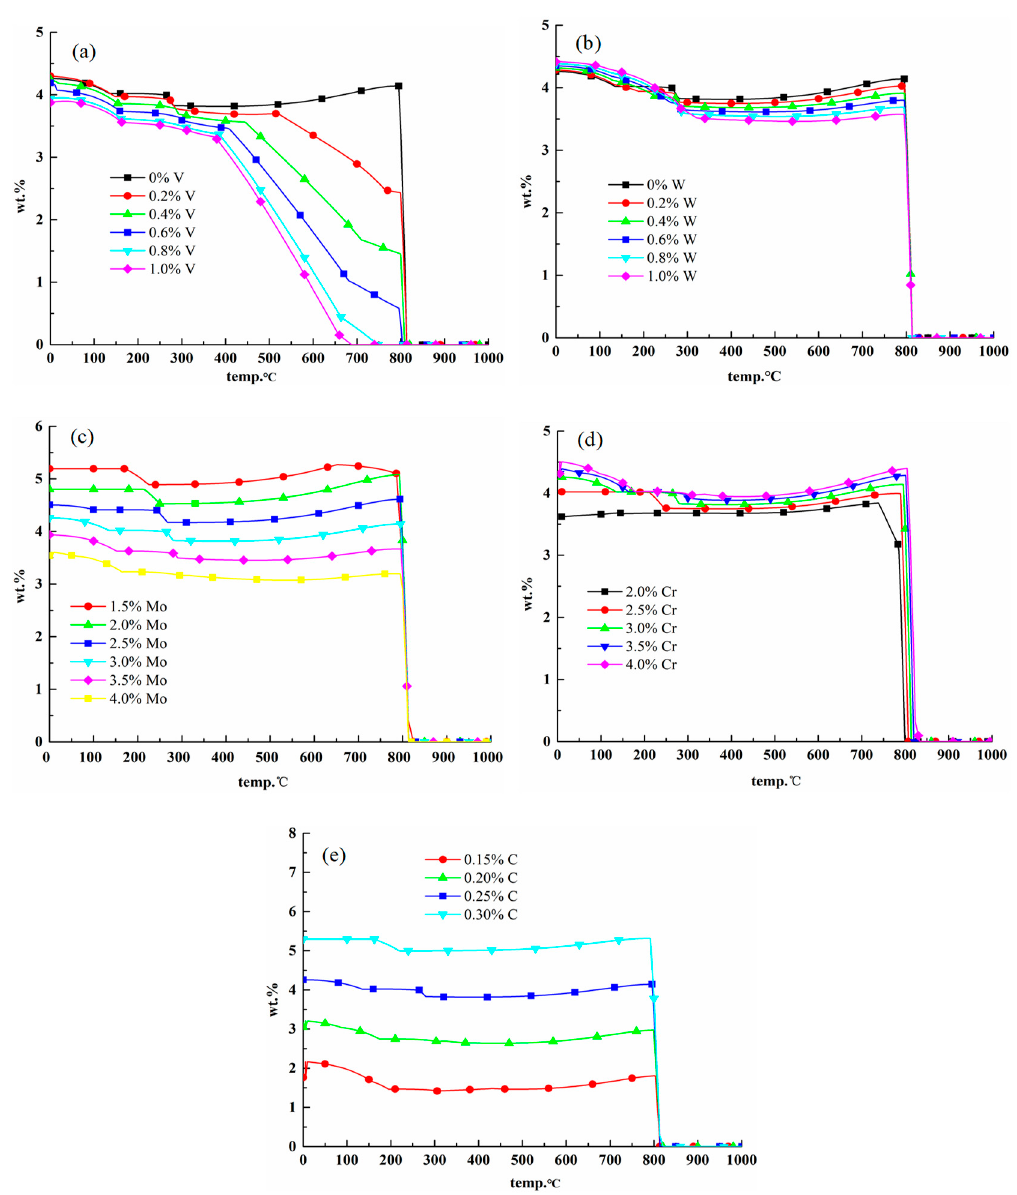
Figure 3. E ff ects of alloying elements on M 23 C 6 carbides. ( a ) E ff ect of V on M 23 C 6 ; ( b ) e ff ect of W on Figure 3. Effects of alloying elements on M 23 C 6 carbides. ( a ) Effect of V on M 23 C 6 ; ( b ) effect of W on M 23 C 6 ; ( c ) e ff ect of Mo on M 23 C 6 ; ( d ) e ff ect of Cr on M 23 C 6 ; ( e ) e ff ect of C on M 23 C 6 M 23 C 6 ; ( c ) effect of Mo on M 23 C 6 ; ( d ) effect of Cr on M 23 C 6 ; ( e ) effect of C on M 23 C 6 .